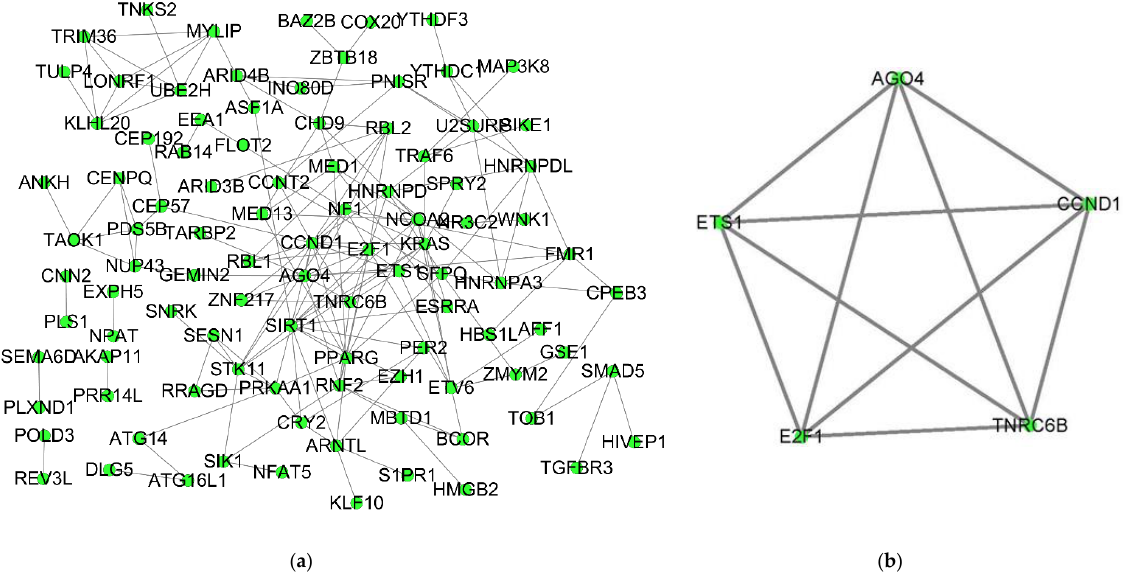
Figure 4. PPI network of DEmRNAs and Cluster 1 using the MCODE plug-in from the whole PPI network. ( a ) PPI network of DEmRNAs in the ceRNA network obtained from the STRING database. ( b ) The first cluster is of PPI followed by the MCODE plug-in of Cytoscape. PPI: Protein-protein interaction; DEmRNAs: differentially expressed mRNAs; MCODE: molecular complex.